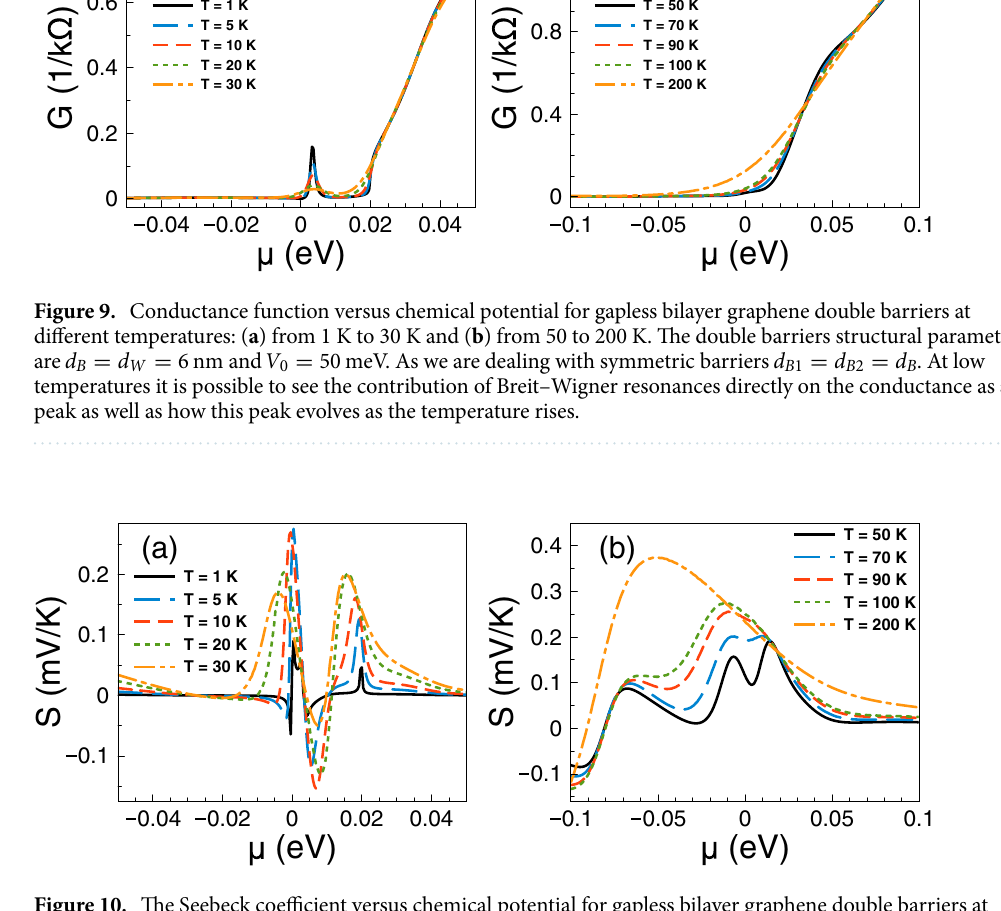
Figure 10. The Seebeck coefficient versus chemical potential for gapless bilayer graphene double barriers at different temperatures: ( a ) from 1 to 30 K and ( b ) from 50 to 200 K. The double barriers structural parameters are the same as in Fig. 9. Here, at low temperatures the charge neutrality point and the Breit–Wigner resonances shape the Seebeck coefficient characteristics, while the Fano resonances energy region become preponderant as the temperature rises, merging with the charge neutrality point and the Breit–Wigner resonances as as single broad peak at high